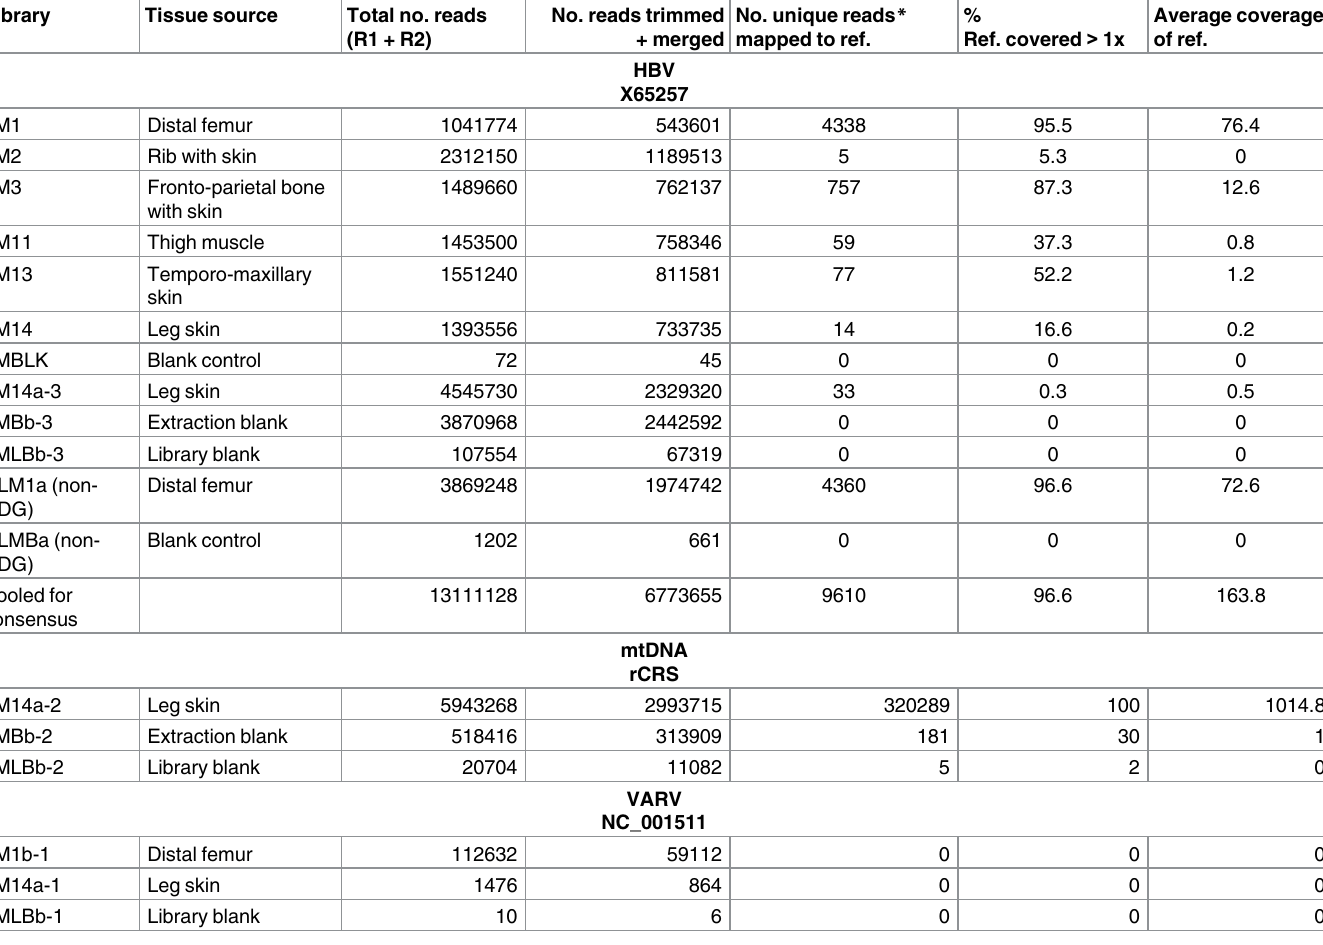
Table 2. Total reads and coveragefor HBV, mtDNA, and/or VARV genomes from various tissue samples.